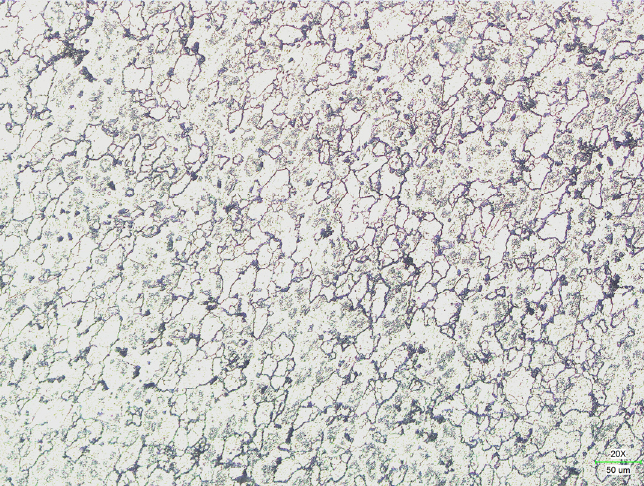
Figure 4. The initial microstructure before Gleeble compression.